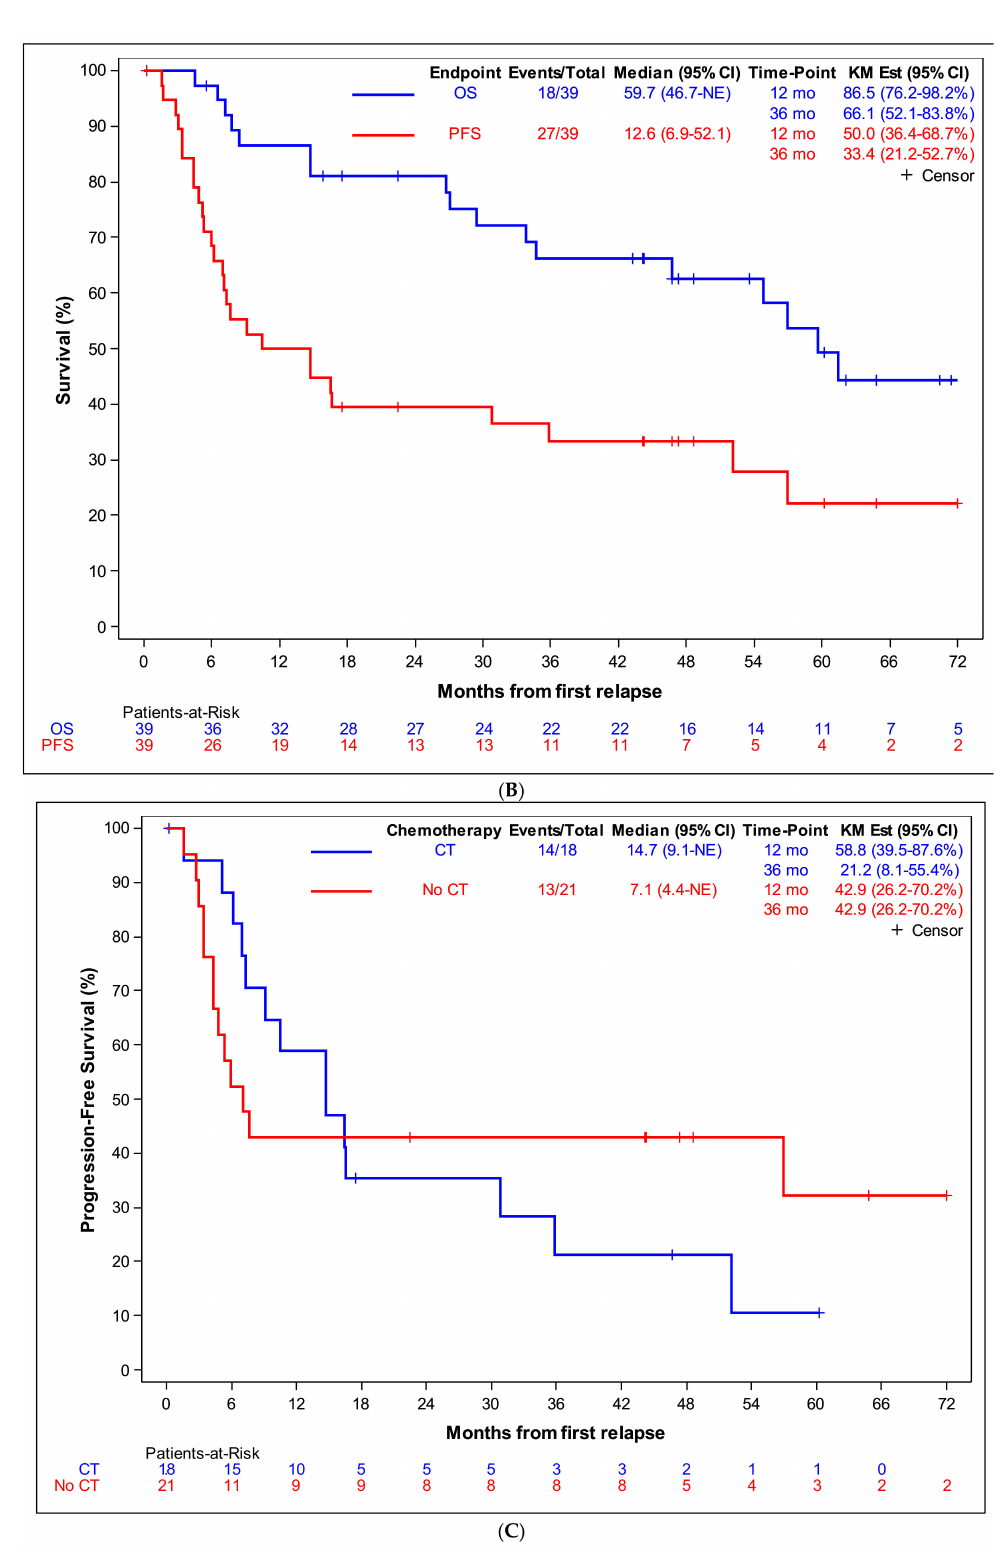
Figure 2. ( A ): Outcome after first osteosarcoma relapse. Overall (blue) and progression-free survival (red) of the whole cohort of 157 patients. ( B ). Outcome after first osteosarcoma relapse: Overall (blue) and progression-free survival (red) of the 39 patients with a unique lung lesion at first relapse. ( C ). Outcome after first osteosarcoma relapse: Progression-free survival of the 39 patients with a unique lung lesion at first relapse, according whether they received (blue) or not (red) a systemic treatment